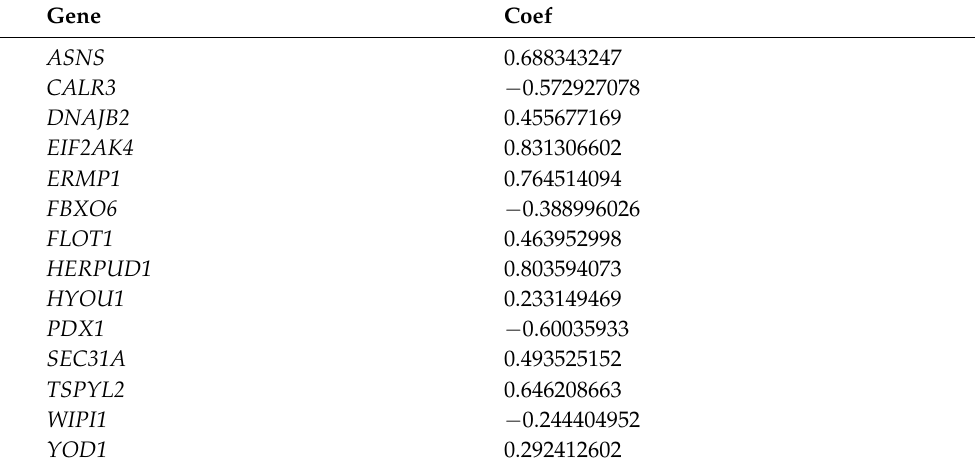
Table 1. Parameters used in the construction of ER stress-related risk